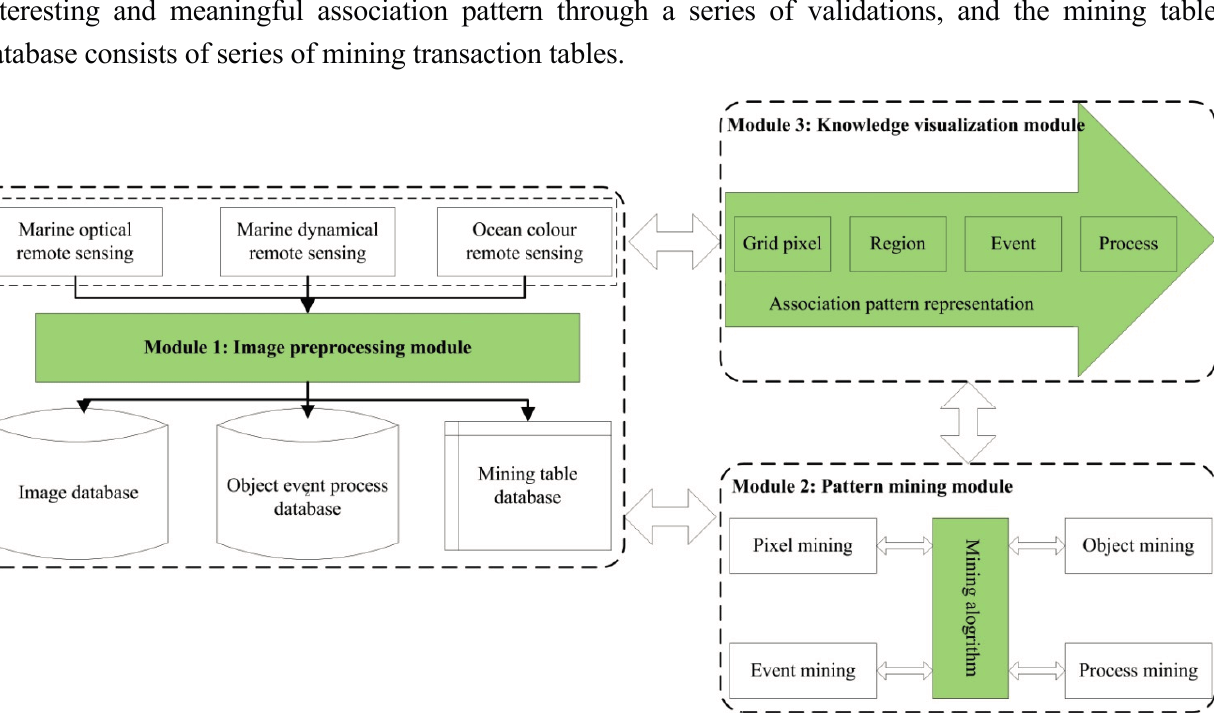
Figure 1. Architecture of Remote Sensing driven Marine spatiotemporal Association Pattern Mining system ( RSMapMining )